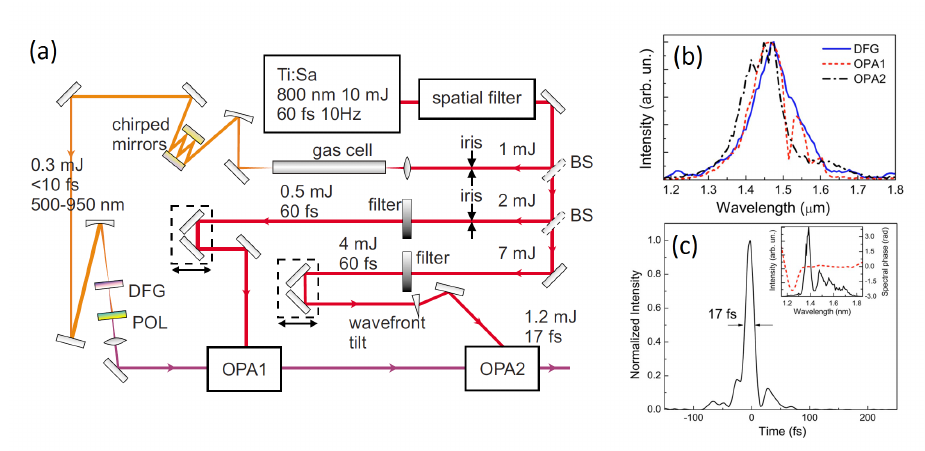
Figure 2. ( a ) Scheme of the Optical Parametric Amplification (OPA) setup for the generation of high- energy Carrier-Envelope Phase (CEP)-stable near-IR pulses: BS, Beam Splitter; Difference Frequency Generation (DFG), 400 µ m-thick BBO crystal; POL, Polarizer; filter, neutral density filter for controlling intensity of the pump beam; ( b ) Spectra of the DFG pulses (solid curve) and of the pulses after the first (dashed curve) and second (dashed–dotted curve) OPA stage in a Type-II phase-matching configuration; ( c ) Temporal intensity profile corresponding to a pulse duration of 17 fs. The inset shows the spectrum of the amplified IR pulses (solid curve) and the retrieved spectral phase (dashed curve). Adapted with permission from [28], Copyright OSA Publishing, 2007. Adapted with permission from [29], Copyright OSA Publishing,